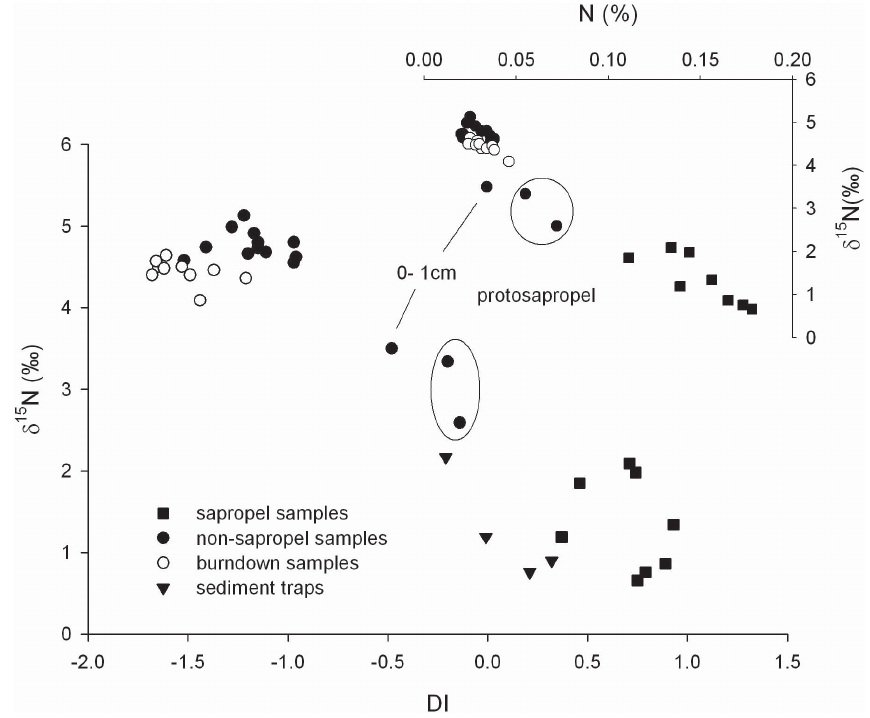
Fig. 4. Mean values of δ 15 N vs. DI in core #569 and mean values from MID sediment traps. Insert: δ 15 N vs. N (%) in core